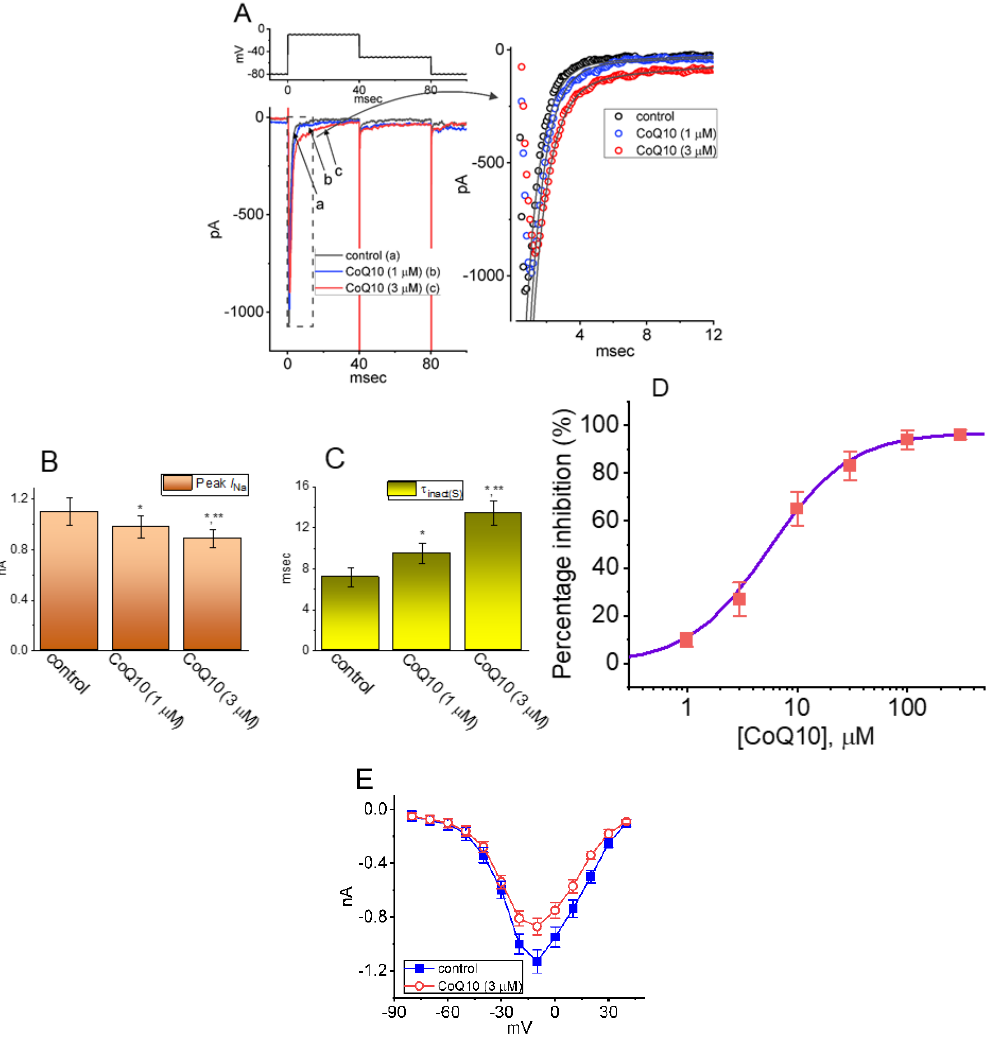
Figure 1. Effects of Ubiquinone (CoQ10) on voltage-gated Na + current ( I Na ) measured from GH 3 pituitary cells. In these experiments, we kept cells immersed in Ca 2+ free Tyrode’s solution containing 10 mM of TEA, and the recording pipette was filled with a Cs + ‐ containing solution. The composition of these solutions is detailed in the Materials and Methods section. ( A ) Representative I Na traces taken (a) during the control period and during cell exposure (b) to 1 μ M of CoQ10 or (c) to 3 μ M of CoQ10. The right side of panel ( A ) indicates an expanded record taken from the dashed box on the left side, while the upper part shows the voltage ‐ clamp profile used. The smooth gray line denotes the double exponential (i.e., the fast and slow components) fit that has been overlaid on the curve representing the current (open symbols). The summary bar graphs shown in ( B ), or ‐ ange bars and ( C ), yellow bars illustrate the effects of CoQ10 (1 and 3 μ M) on both the amplitude and the slow component of the inactivation time constant ( τ inact(S) ), respectively, of the I Na evoked in response to brief depolarizing voltage steps. Both the amplitude (i.e., at the beginning of voltage pulse) and the inactivation time constant (i.e., τ inact(S) of the current with and without the addition of CoQ10) were measured when the GH 3 cells were depolarized from − 80 to − 10 mV in a period of 40 ms. Each point represents the mean ± SEM (n = 8). * Significantly different from the control group ( p < 0.05) and ** significantly different from the addition of CoQ10 (1 μ M) alone group ( p < 0.05). ( D ) The concentration ‐ dependent inhibition of the peak I Na produced by CoQ10. Each cell was volt ‐ age ‐ clamped at − 80 mV, and the current amplitude recorded during cell exposure to different concentrations of CoQ10 was measured at the start of a 40 ms ‐ long depolarizing voltage step to − 10 mV. The values of IC 50 , n H, and E max related to the CoQ10 ‐ induced inhibition of the peak I Na were estimated to be 5.6 μ M, 1.2, and 97%, respectively. The continuous sigmoidal curve, over which the data points were overlaid, demonstrates the best fit to the modified equation indicated in the Ma ‐ terials and Methods section. ( E ) Steady ‐ state current versus voltage ( I–V ) relationships of peak I Na obtained in the absence ( ■ ) and presence ( ○ ) of 3 μ M CoQ10 (mean ± SEM; n = 7 for each point). Peak current amplitude was measured at the start of each depolarizing voltage step. We further examined the relationship between the concentration of ubiquinone and the percentage of inhibition of the peak I Na . Figure 1D illustrates that the peak amplitude of the I Na activated during a short step depolarization from − 80 to − 10 mV was variously depressed in the presence of ubiquinone depending on its concentration, with an esti ‐ mated IC 50 of 5.6 μ M, and ubiquinone at a concentration of 100 μ M decreased I Na by ap ‐ proximately 97%. Figure 1E illustrates the overall I–V relationships of peak I Na with or without cell exposure to 3 μ M ubiquinone, reflecting that ubiquinone did not alter the I– V curve of the current. Therefore, the results indicate, first, that, under our experimental conditions, the I Na remained functionally active in the GH 3 cells [21,23,26,27,34,38], and, second, that the presence of ubiquinone may play a modulatory role in relation to the magnitude and the inactivation time course of the I Na produced by the abrupt depolari ‐ zation of the cell membrane. 3.2. Comparison between the Effects of Ubiquinone Alone and Those of Ubiquinone Plus Menadione, Ubiquinone Plus Superoxide Dismutase, and Ubiquinone Plus Tefluthrin (Tef) on the Peak I Na Oxidative stress readily affects the integrity of the cell membrane, and redox rea ‐ gents may react with essential cysteine groups located on the channel proteins [16,39,40]. Therefore, the effects of ubiquinone alone, as well as those of ubiquinone plus menadi ‐ one, ubiquinone plus superoxide dismutase, and ubiquinone plus tef on the peak I Na